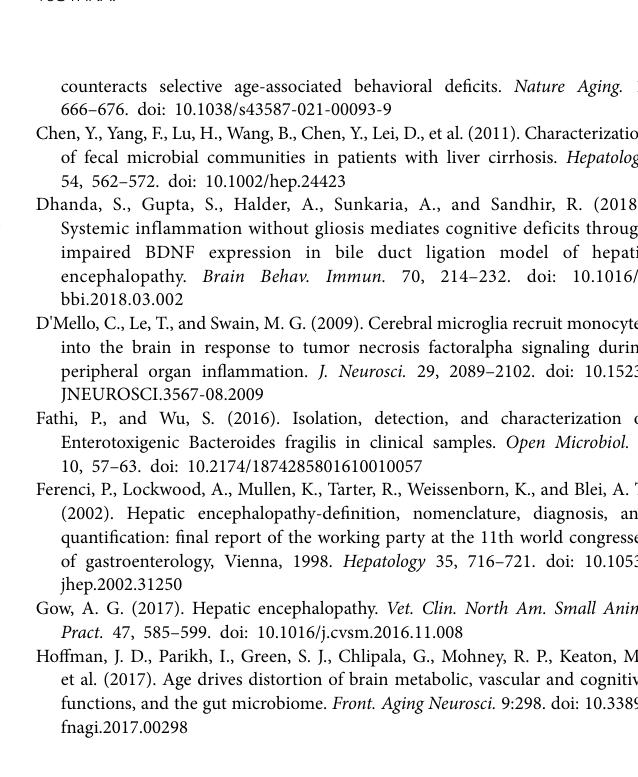
Supplementary Figure 1 | Relative abundance of gut microbiota. Data are presented as the mean ± SEM. ** p < 0.01; *** p < 0.001; **** p < 0.0001; ns, not significant. Supplementary Figure 2 | Relative abundance of gut microbiota. Data are presented as the mean ± SEM. * p < 0.05; ** p < 0.01; *** p < 0.001; **** p < 0.0001; ns, not significant. Supplementary Figure 3 | Relative abundance of gut microbiota. Data are presented as the mean ± SEM. * p < 0.05; ** p < 0.01; *** p < 0.001; **** p < 0.0001; ns, not significant. Supplementary Figure 4 | KEGG pathway prediction heat map based on 16S